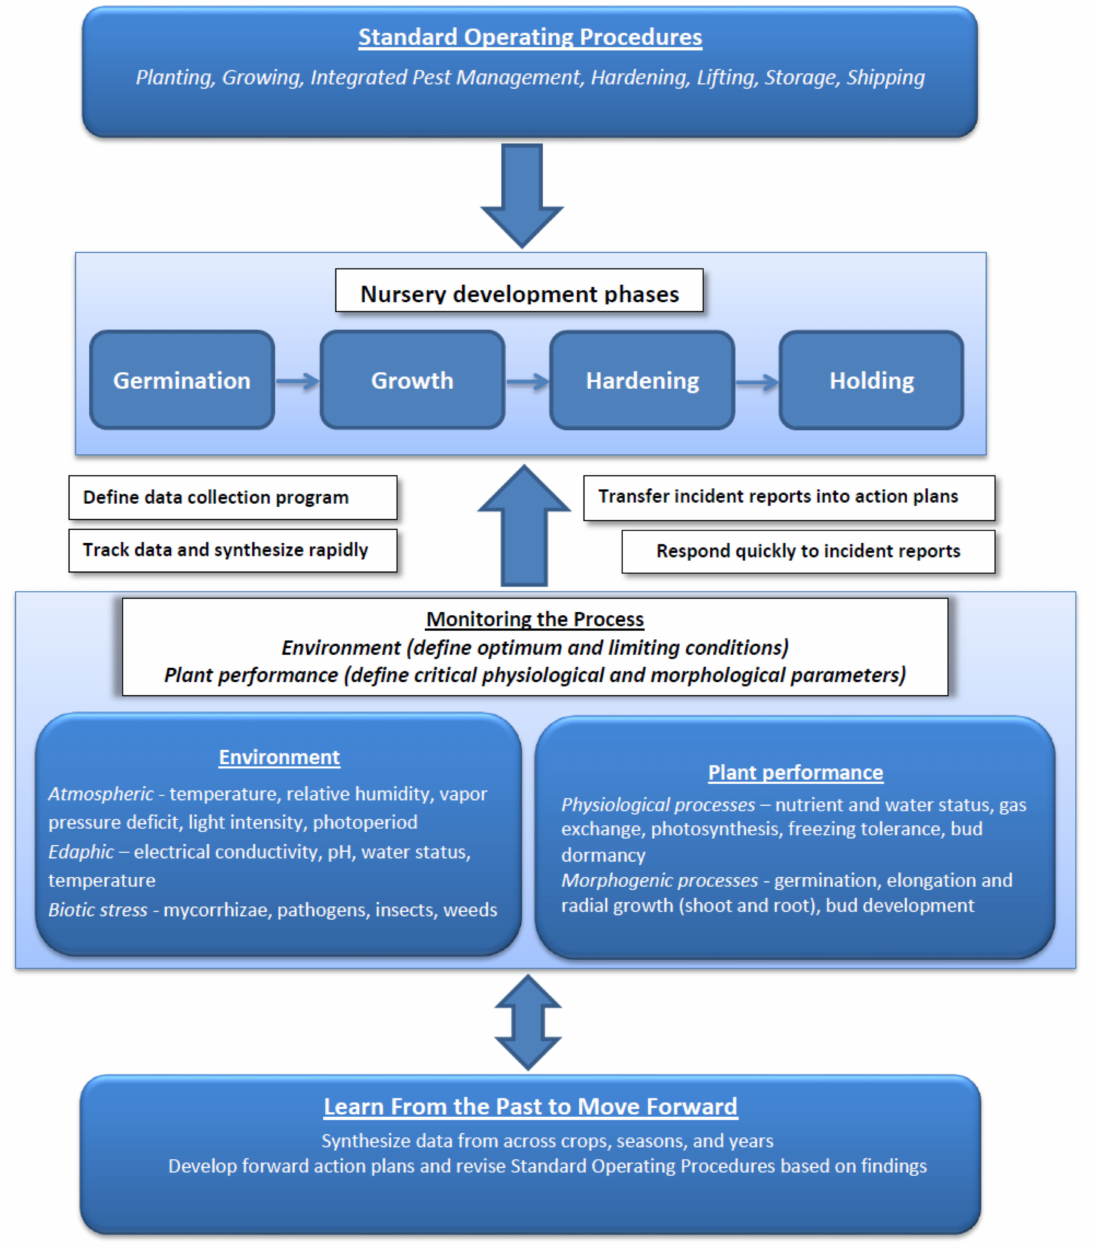
Figure 1. Conceptual model for monitoring seedling quality during crop development in the